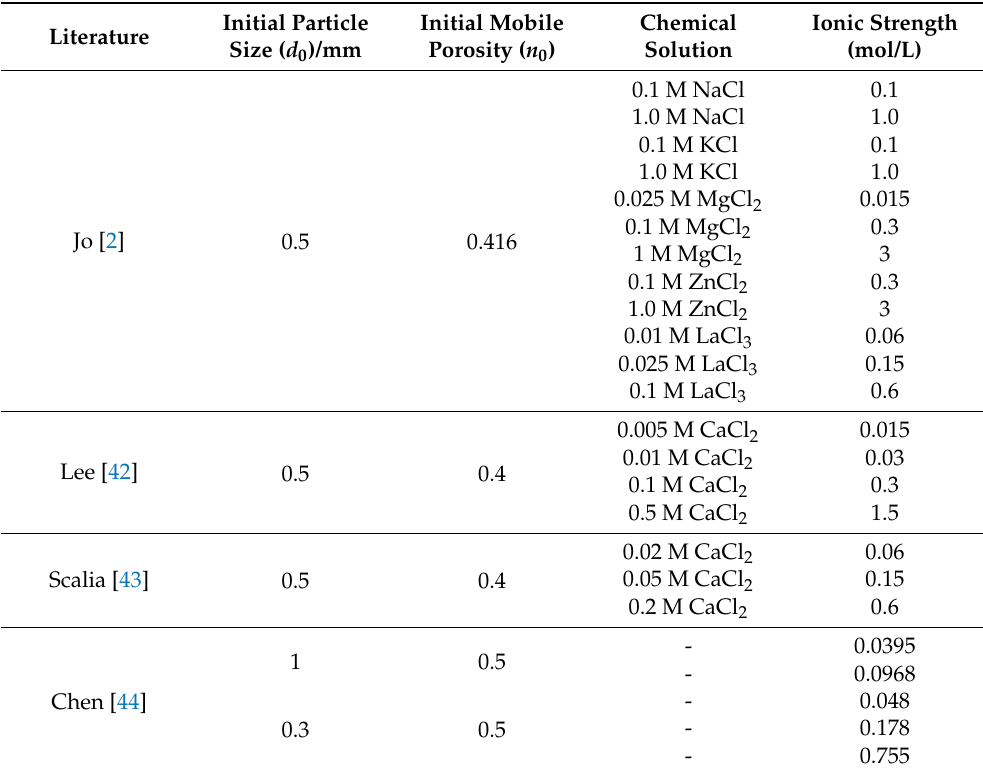
Table 3. The experimental hydraulic conductivity of the GCLs